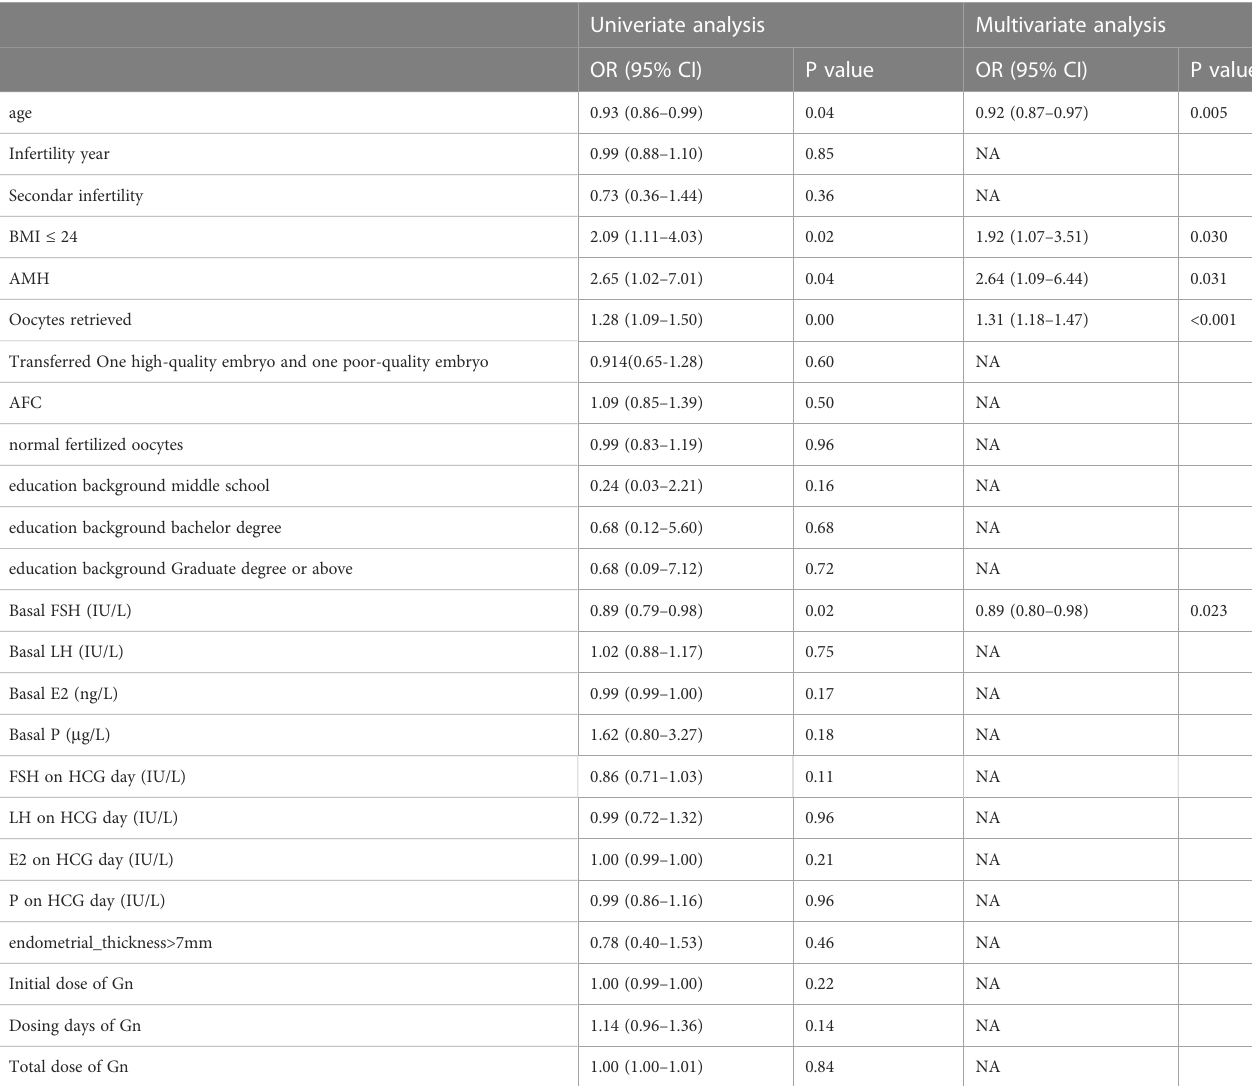
TABLE 2 Univariate and multivariate logistic regression models in the training